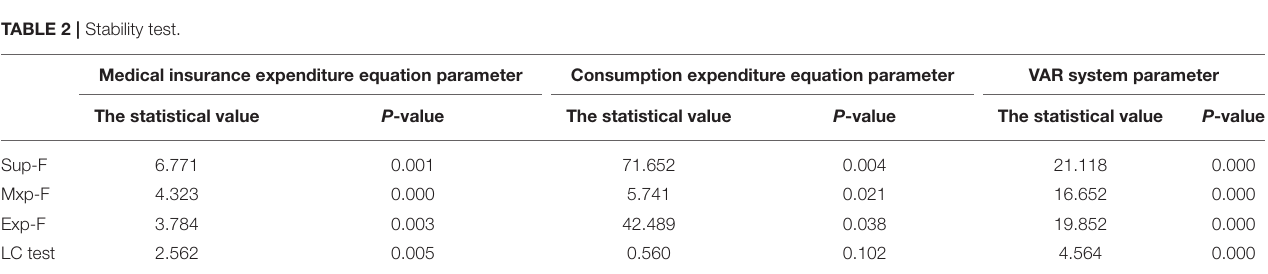
TABLE 2 | Stability